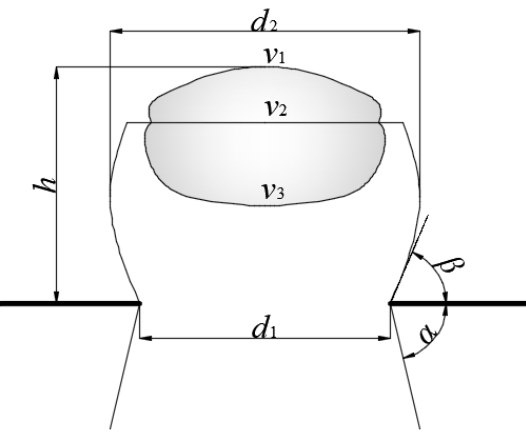
Figure 6. Characteristic parameters of debris cloud.